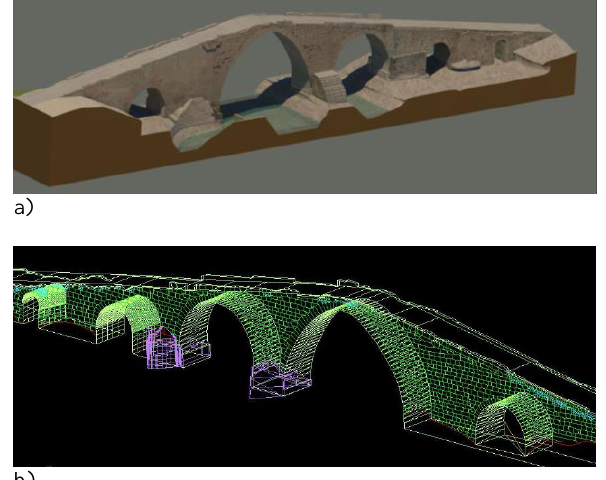
Figure 8. A complex view on the Nahúm´s shrine, Alqosh